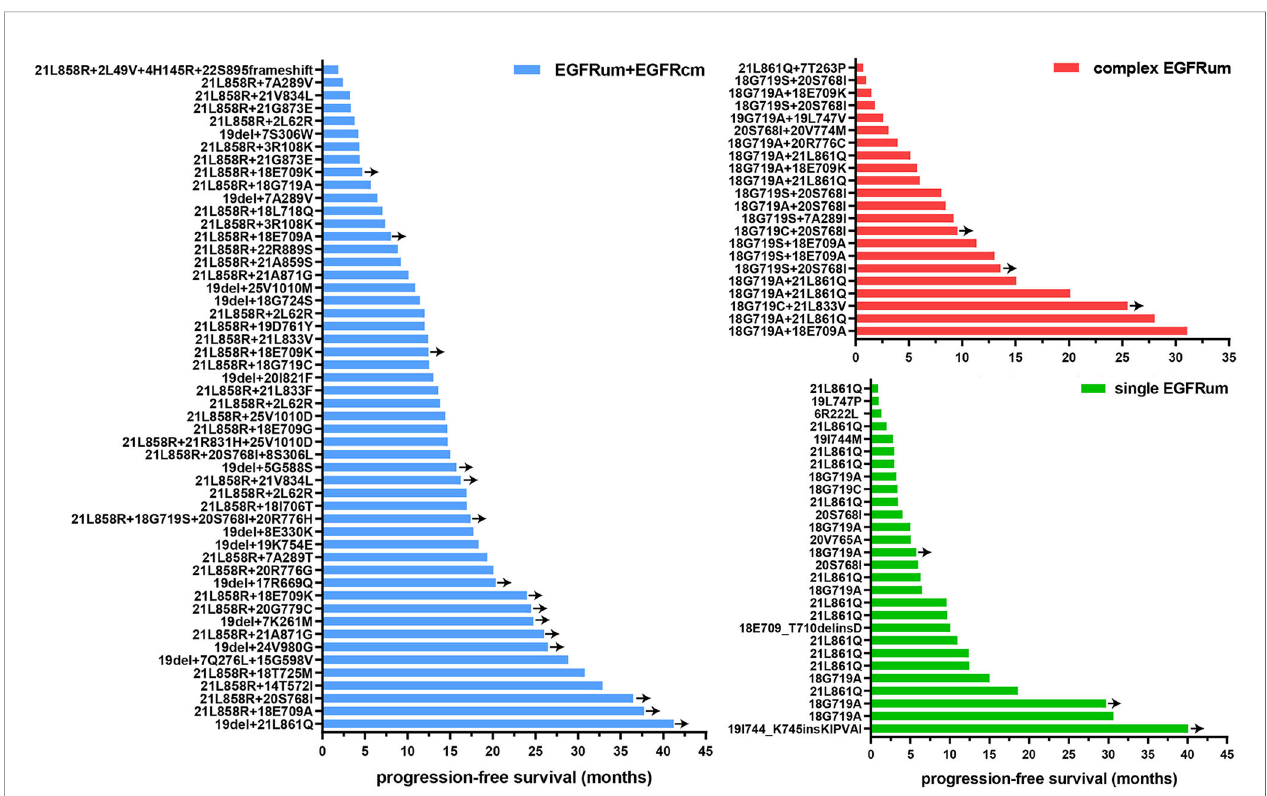
FIGURE 3 | The progression-free survival (PFS) time for patients with speci fi c mutation patterns received EGFR -TKIs as fi rst-line therapy. Y-axis denotes mutation pattern, and x-axis indicates PFS. EGFR cm, common EGFR mutations; EGFR um, uncommon EGFR